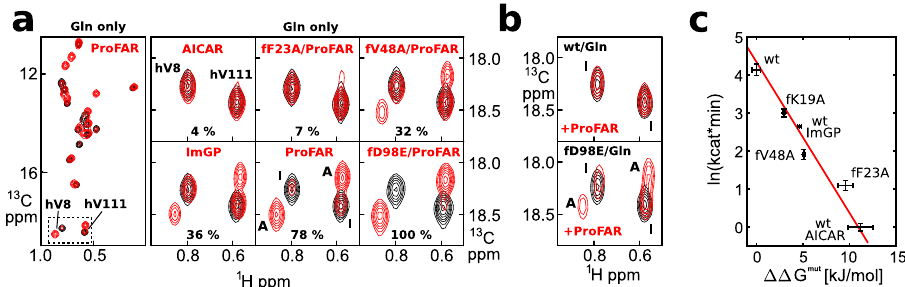
Fig. 4 The activity of HisFH is correlated with the population of the active conformation. a Methyl TROSY spectra of NMR active HisH (hC84S background) that is incorporated in the HisFH complex either in the presence of saturating concentrations of Gln (black) or in the presence of saturating amounts of Gln and ProFAR (red). Weak signals of the inactive conformation are still present in the HisFH/Gln/ProFAR complex (left), indicating that the complex does not fully adopt the active conformation. The populations of inactive and active conformations are shifted by different HisF ligands and mutations (right, closeups of the hV8 and hV111 signals are shown). The populations of the active conformation are given at the bottom of the spectrum and the signals of the inactive (I) and active (A) conformations are labeled in the spectrum of the WT HisFH complex in the presence of ProFAR. b Methyl TROSY spectra of NMR active HisH in a fully active HisFH complex during catalytic turnover. Close-ups for hV8/hV111 in the presence of Gln/ProFAR during catalytic turnover (red) are shown for WT HisFH (top) and for the hyperactive HisFH – fD98E complex (bottom). The signals of the inactive (I) and active (A) conformations are labeled in the spectra. Under multiple turnover conditions, the active conformation is observed only for the fD98E mutant. Spectra of the inactive conformation (before addition of ProFAR) are shown in black. c Correlation between ln( k cat ) of HisFH and ΔΔ G mut of the active conformation for different mutants/ ligands. A linear fi t with a slope of ( − RT) − 1 is shown (red line). This implies that the glutamine turnover rates in HisFH are directly determined by the population of the active conformation. Data are presented as mean values ± 1 standard deviation (based on 8 resonances ( x - axis) or ≥ 28 timepoints( y -axis)). Source data are provided as a Source data fi in good agreement with the value calculated from the apparent determine the populations of the inactive and active conforma- Gln-dissociation constants (Fig. 3b), which predict a population tions we used HisFH complexes that contain the hC84S mutation of 86 ± 7% active conformation under saturating concentrations as this is compatible with long-term NMR experiments. In the of ProFAR and Gln. Under these conditions we determined presence of saturating amounts of Gln and ProFAR the peak that the WT HisFH complex shows a glutaminase activity ( k cat ) volumes of the inactive and active conformation indicate that 78 ± 3% of the complex is in the active conformation. This result is of 63 min − 1 .